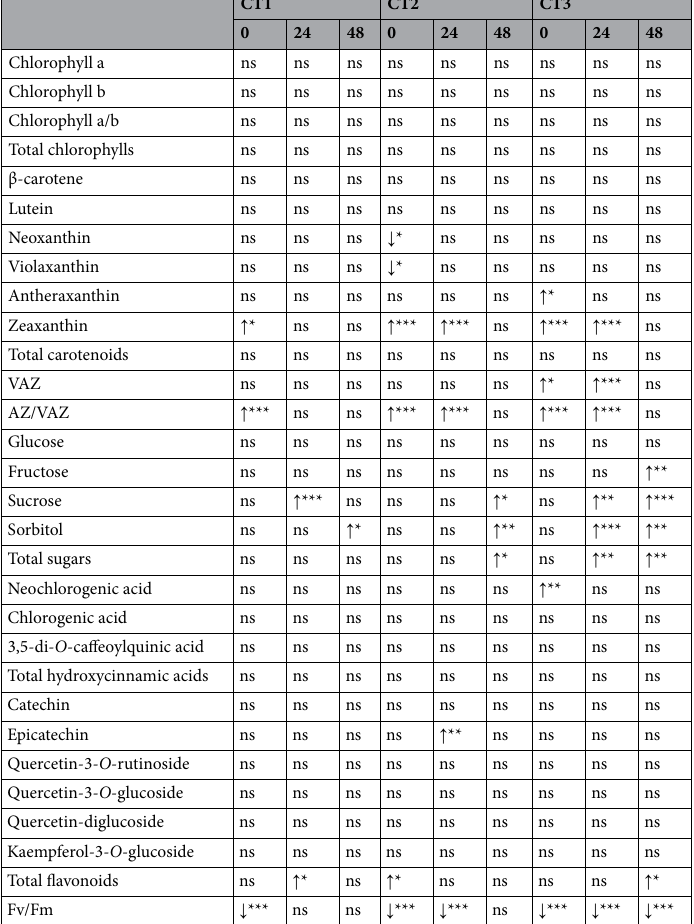
Table 2. The results of the contrast analysis of the selected biochemical and physiological parameters in sweet cherry leaves exposed to one (CT1), two (CT2) or three (CT3) overnight chillings, sampled at time 0, 24 and 48 and compared to control in Experiment II. *Statistically significant differences at P < 0.05; **statistically significant differences at P < 0.01; ***, statistically significant differences at P < 0.001; ns, not significant. ↑ = increase in chilled leaves; ↓ = decrease in chilled leaves; –, not monitored. VAZ, xanthophyll cycle pigments; AZ/VAZ, deepoxidation state of xanthophyll cycle pool; Fv/Fm, maximum quantum yield of PS